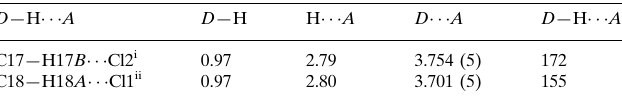
Hydrogen-bond geometry (A˚ , (cid:3)